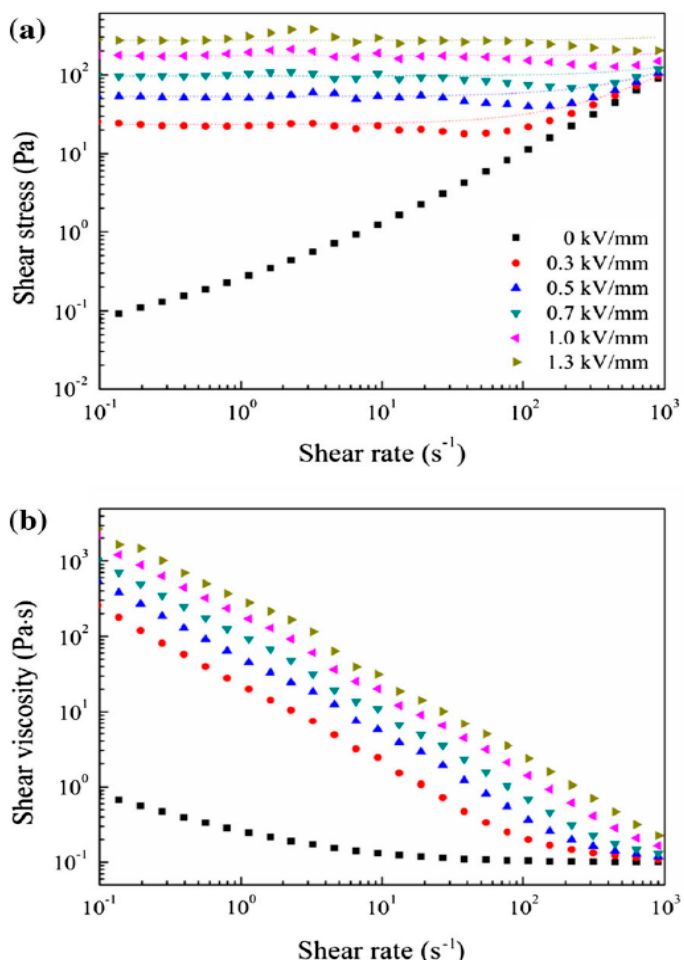
Figure 6. ( a ) Shear stress vs. shear rate; and ( b ) shear viscosity vs. shear rate of MCC ER fluid under a series of external electric field strengths. The dotted line in ( a ) is calculated from the Bingham equation (reproduced from [93]).